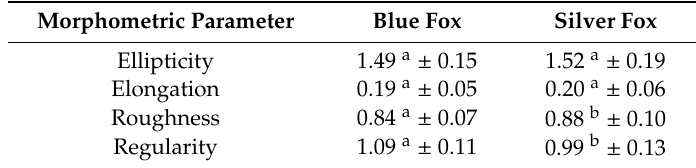
Table 3. Sperm head morphology in fox sperm according to Tygerberg strict criteria. Di ff erent superscript letters designate significant di ff erences between means within rows at p ≤ 0.05 (mean ± standard deviation). Table 3 . Sperm head morphology in fox sperm according to Tygerberg strict criteria. Different superscript letters designate significant differences between means within rows at p ≤ 0.05 (mean ± standard deviation).